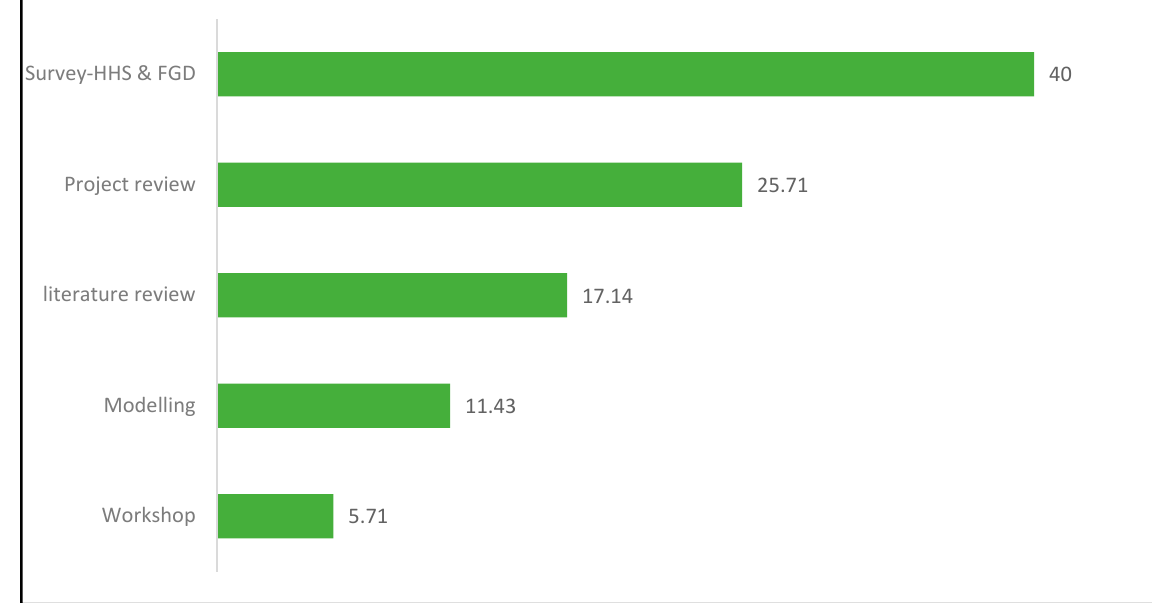
Figure 2. Methodological approach usage in CS project analysis (%). Table 1. List of the 50 kinds of literature analyzed for this study.